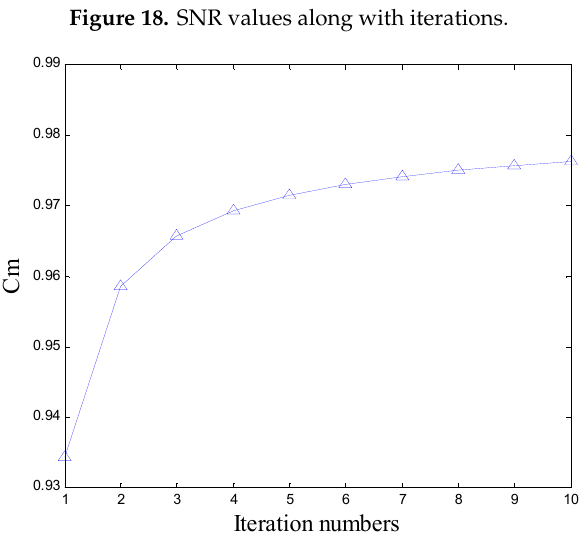
Figure 20. MSE values along with iterations. Table 2. The denoising indicators with different noise levels before and after denoising. SNR of added noise